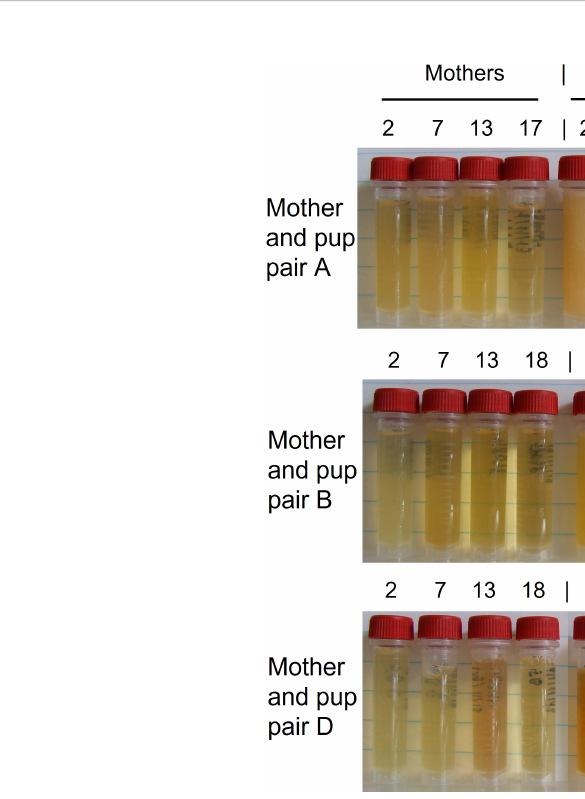
FIGURE 1 Appearance of serum samples of mother and pup Atlantic grey seals at the times indicated after birth. Pups ’ sera showed initial and increasing turbidity with time (also likely affected by time since suckling), indicative of increasing content offats and other lipids, whereas maternal sera show little change. The turbidity of sera will be affected by both the content offats and other lipids and how they are emulsi fi ed by incorporation into lipoprotein particles. The samples had been stored frozen until thawed. Adapted from supplement to ref. (Watson et al.,